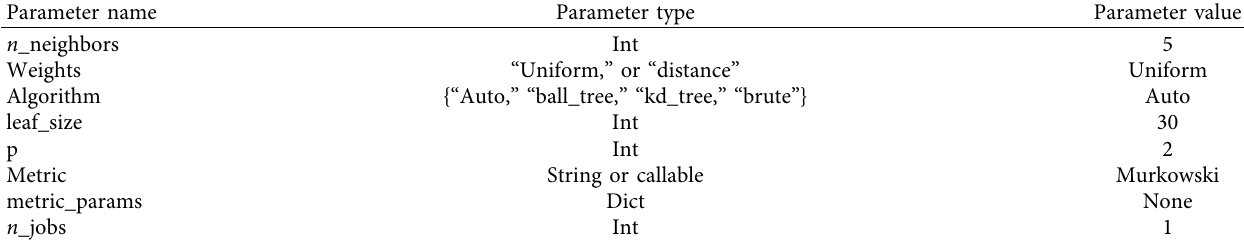
Table 4: The value of eight parameters of KNR.